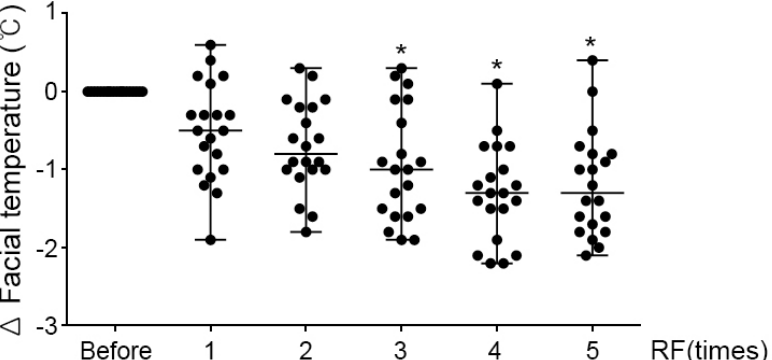
Figure 5. Effects of RF irradiation on the burning sensation in patients with rosacea. The burning sensation in patients with rosacea was measured on facial temperature after RF irradiation 1 to 5 times. The graph showed the results of measurements before the procedure (before) and the amount of temperature change (delta) measured after each RF procedure (1st-5th). * p < 0.05 vs. before RF irradiation.